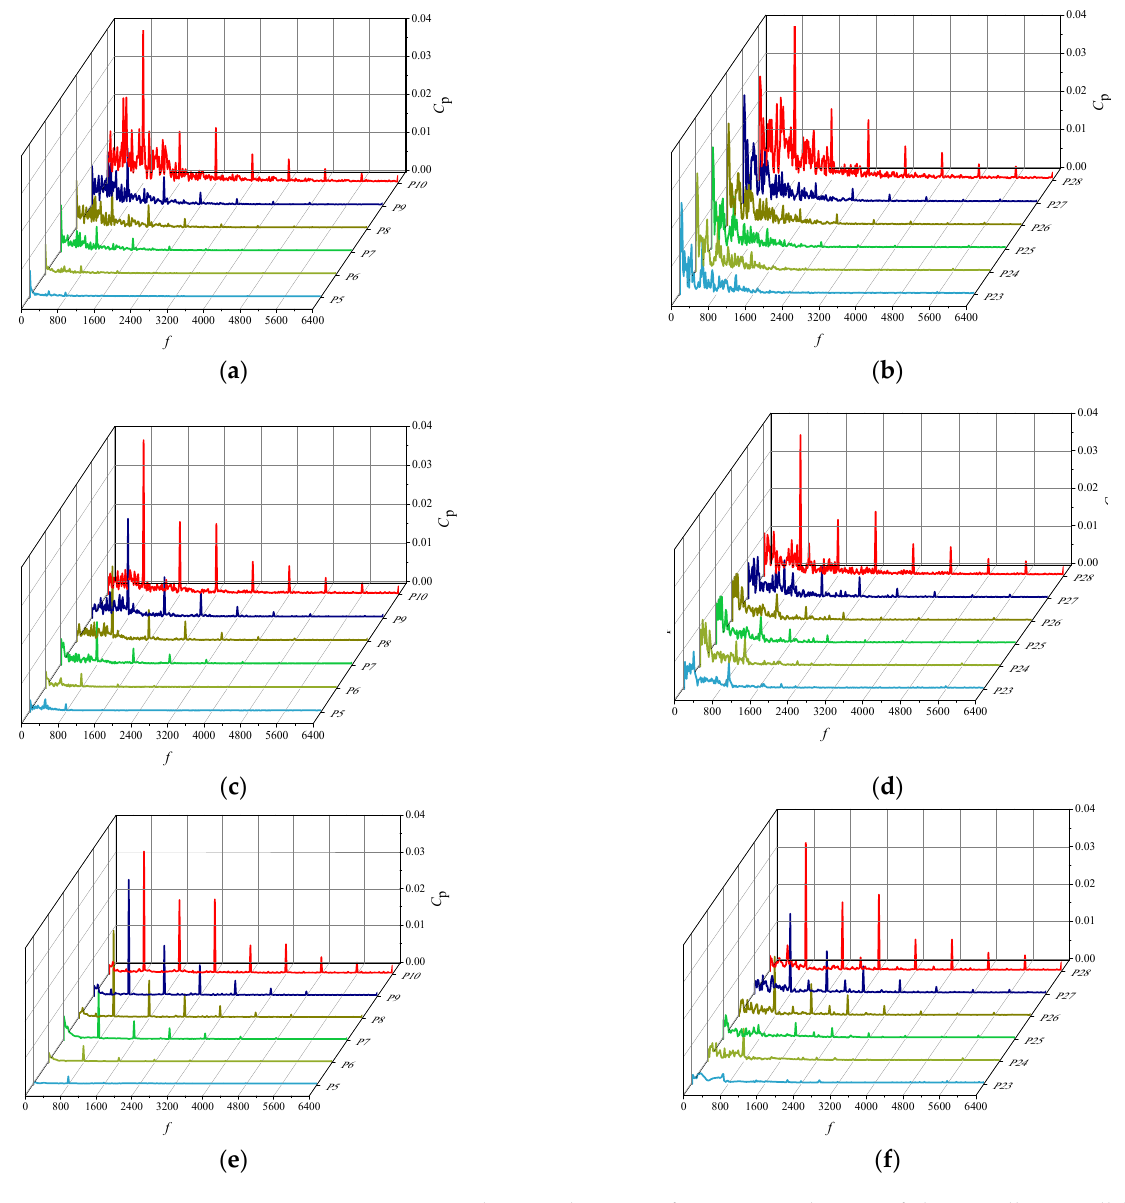
Figure 10. F requency domain diagram of pressure pulsation of the impellers at all levels under non-cavitation conditions: Figure 10. Frequency domain diagram of pressure pulsation of the impellers at all levels un- ( a ) 0.6 Q des − primary impeller; ( b ) 0.6 Q des − secondary impeller; ( c ) 1.0 Q des − primary impeller; ( d ) 1.0 Q des − secondary impel- der non-cavitation conditions: ( a ) 0.6 Q des − primary impeller; ( b ) 0.6 Q des − secondary ler; ( e ) 1.4 Q des − primary impeller and ( f ) 1.4 Q des − secondary impeller.